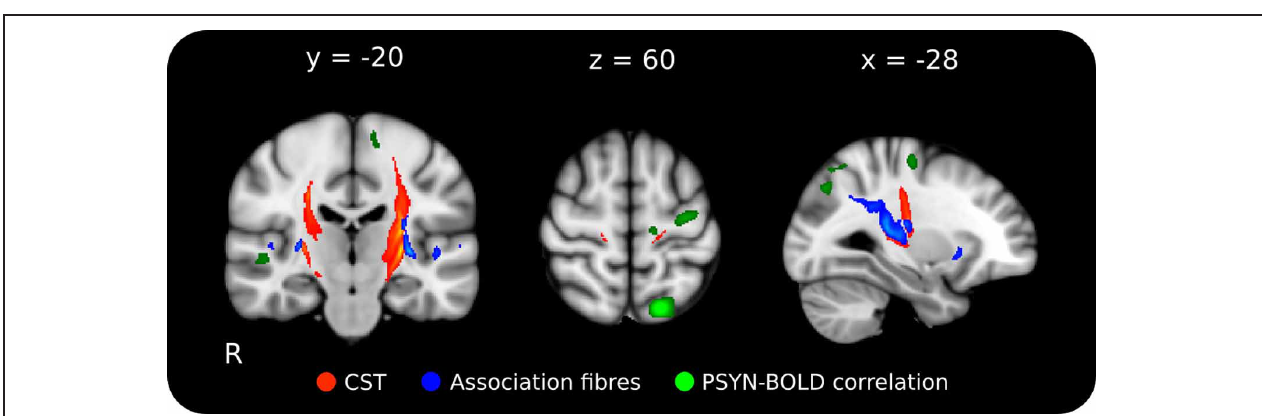
FIGURE 4 | Mean probabilistic tractography results for each target region, originating from the performance-FA seed mask. Red-Yellow: tract resulting from the ascending/descending waypoint masks; Blue-Lightblue: tracts resulting from the lateral waypoint masks; Green: functional correlation between synchronization performance and BOLD across the 5 days of the experiment ( p < 0 . 001, cluster corrected). The delineation between the ascending/descending fibers of the CST and